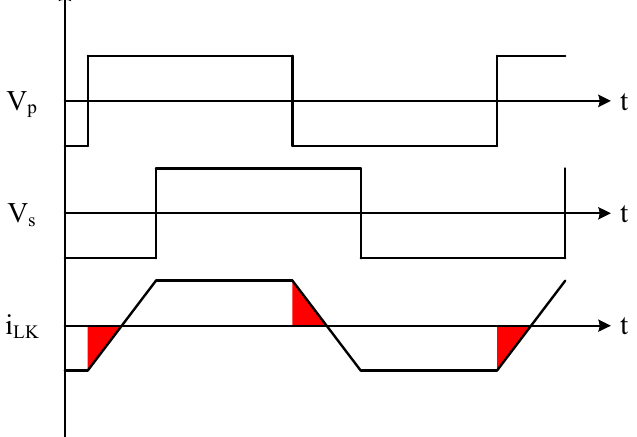
Figure 3. Backflow power in SPS control.